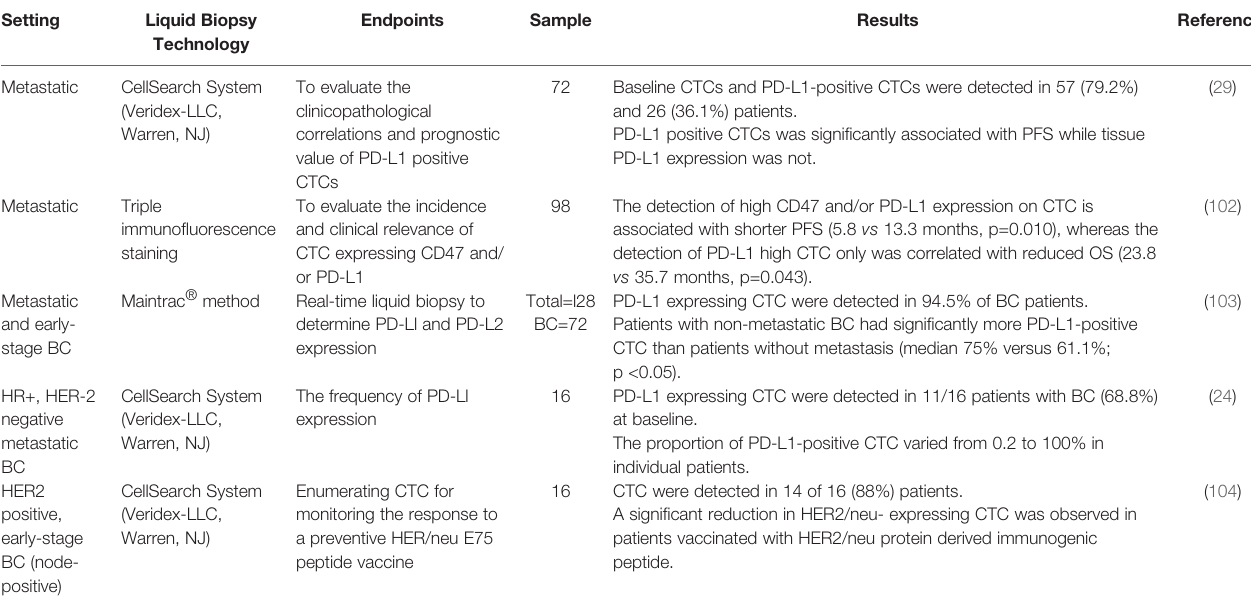
TABLE 2 | Studies on CTC in breast cancer patients receiving immunotherapy.